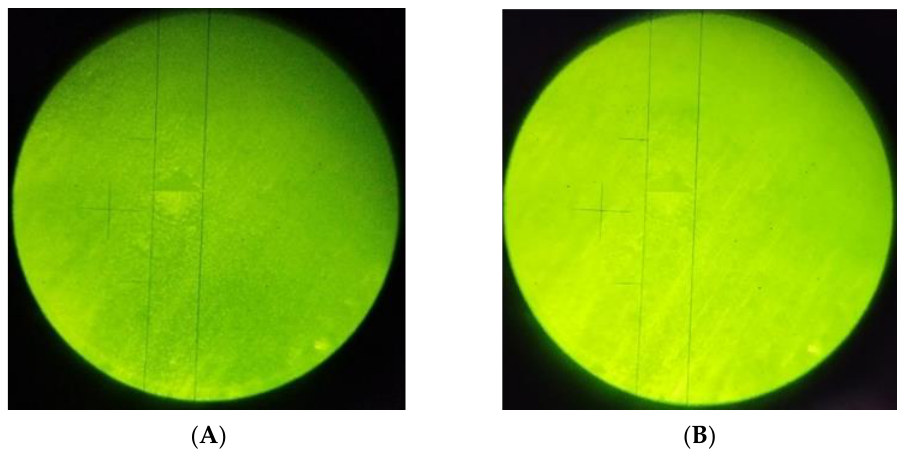
Figure 5. ( A ) Tetric N-Ceram Bulk Fill without OIL control; ( B ) Tetric N-Ceram Bulk Fill with OIL control.